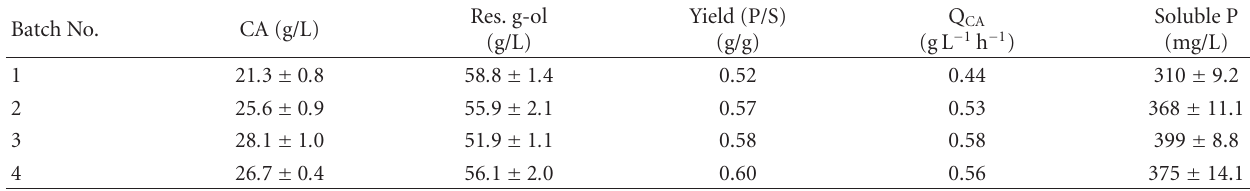
Table 3: Repeated batch citric acid production and simultaneous animal bone char solubilization by k-carrageenan-entrapped cells of Yarrowia lipolytica employed in a repeated-batch fermentation process. Batch No.